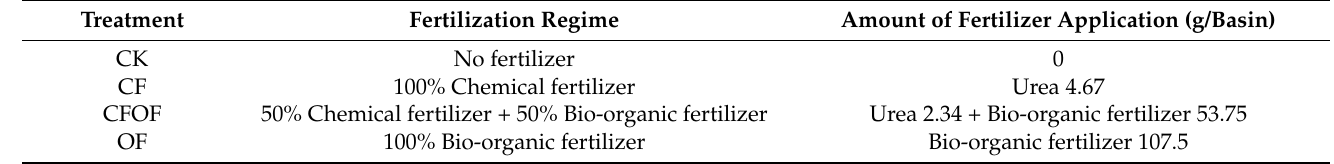
Table 1. Different experimental groups and fertilizer dosages.